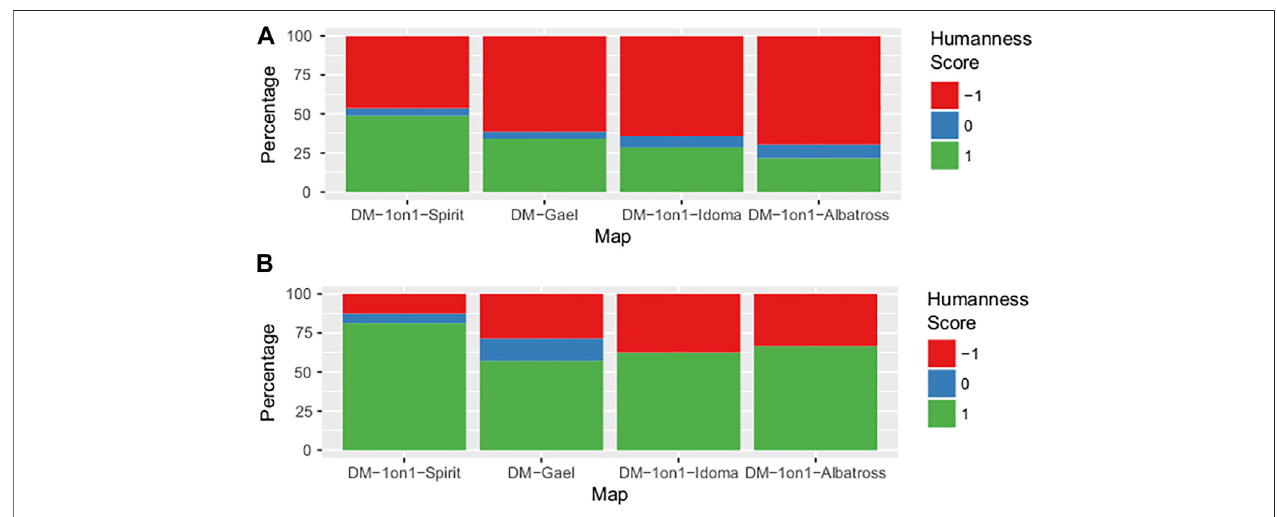
FIGURE 4 | Bar plot of the humanness score for (A) bots and (B) humans depending on the maps.